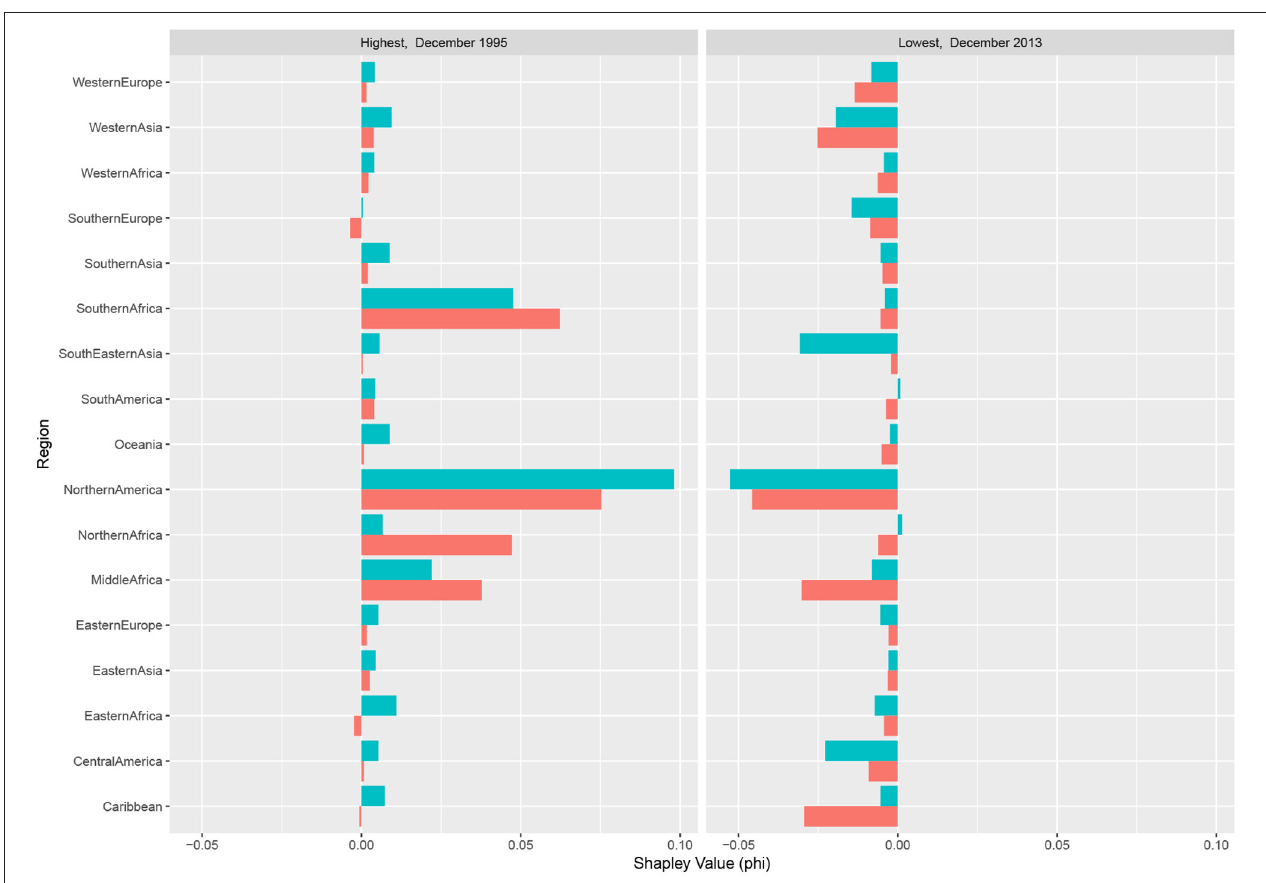
FIGURE 4 | Shapley values for December 1995 (strong price increase) and December 2013 (strong price decrease). The decompositions show the contributions of the producing regions to two extreme relative price changes (regional production in red, and yields in blue). At a given date, the sum of the regional Shapley values is equal to the price change